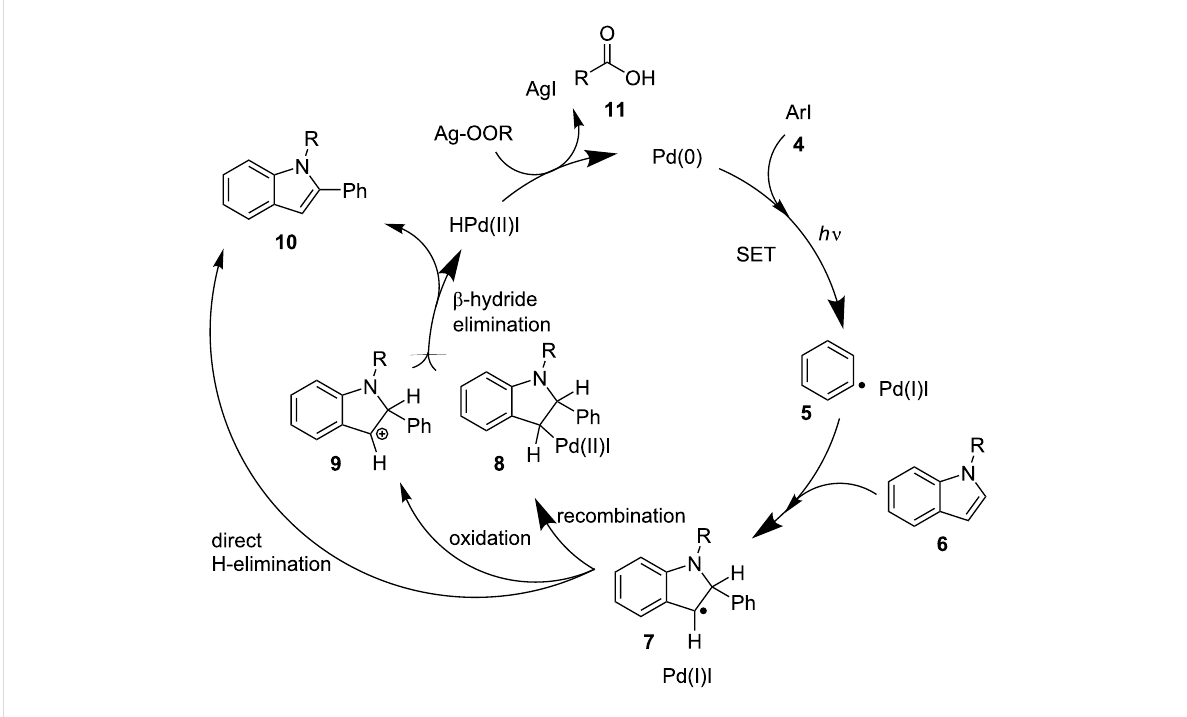
Scheme 3: Proposed mechanism for palladium radical involved reaction between indole and iodobenzene.